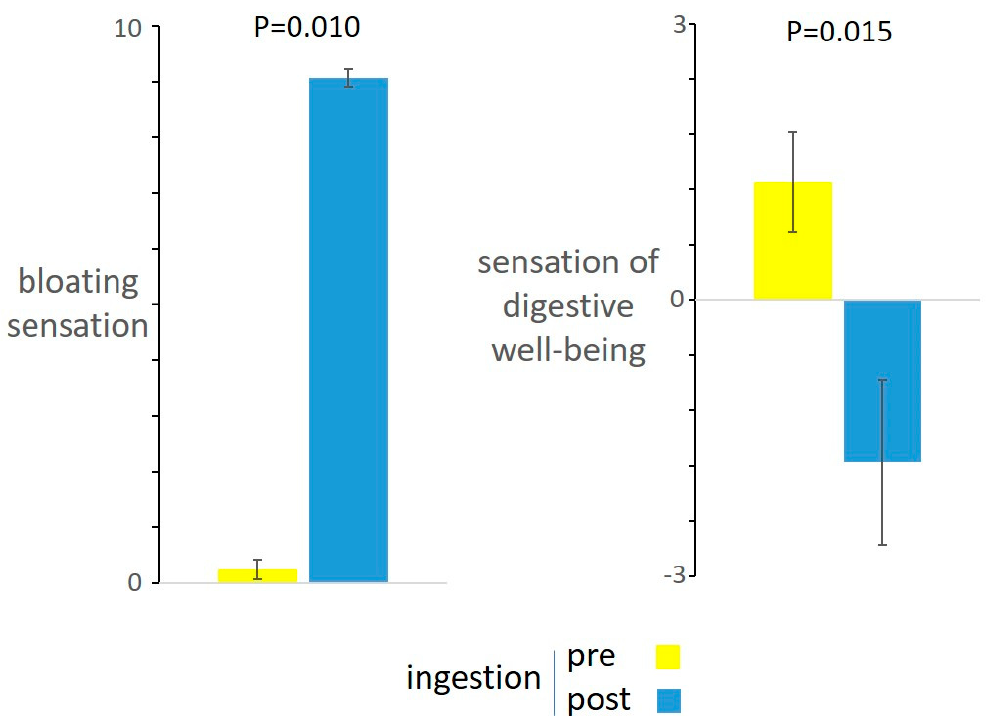
Figure 1. Responses to meal ingestion. The challenge meal induced bloating sensation and impaired sensation of digestive well-being.